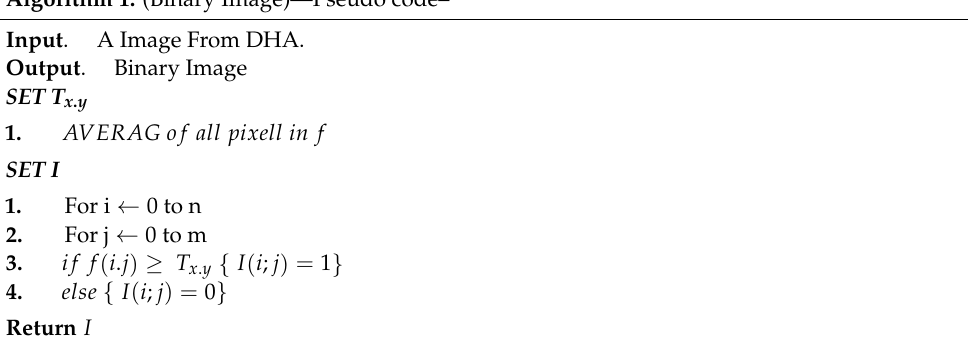
Algorithm 1. (Binary Image)—Pseudo code–